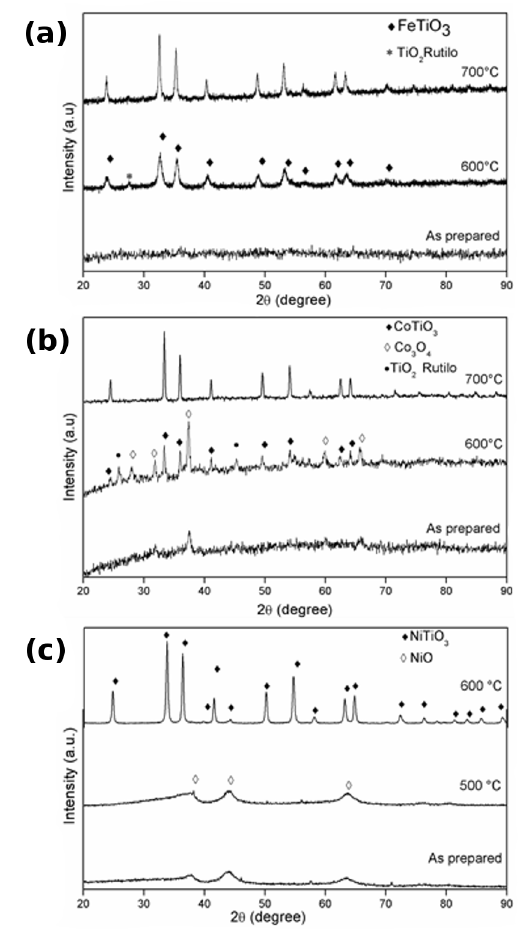
(b) CoTiO and 3 3